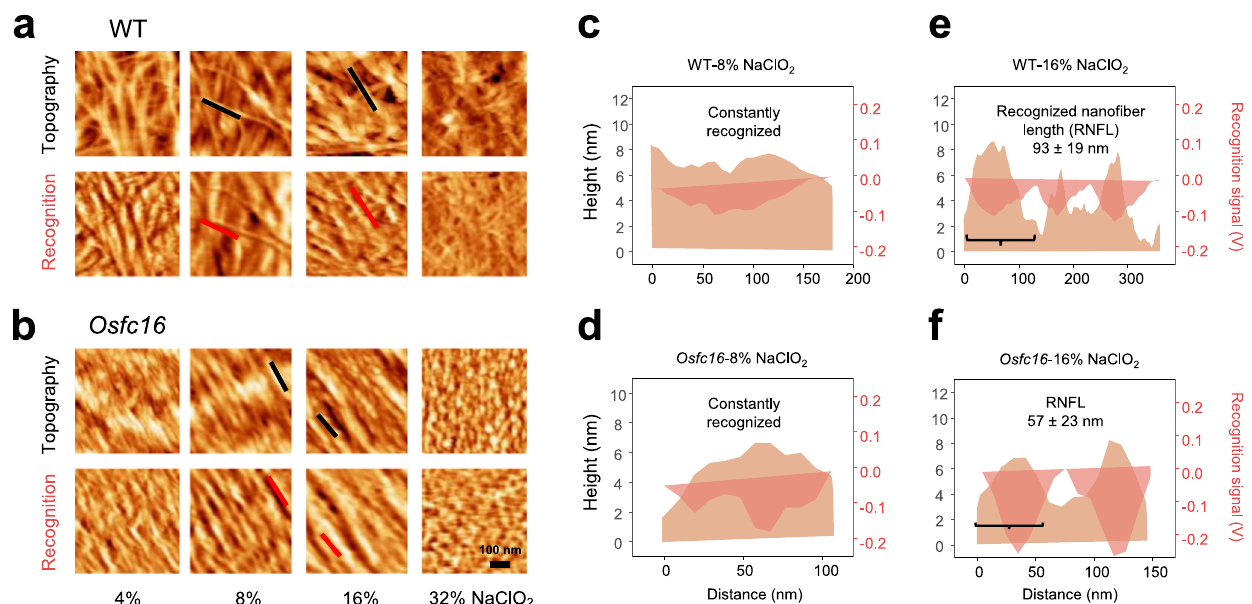
Fig. 3 | Recognition of CMFs and CNFs in WT and Osfc16 mutant. a , b CBM3a- probed AFM topography and corresponding recognition images after NaClO 2 treatments at different concentrations. Black and red lines indicate fi bers in topography and recognitionimages, respectively. c , d Crosspro fi lecorresponding for black and red lines to recognize CMFs (8% NaClO 2 ). e , f Cross pro fi le